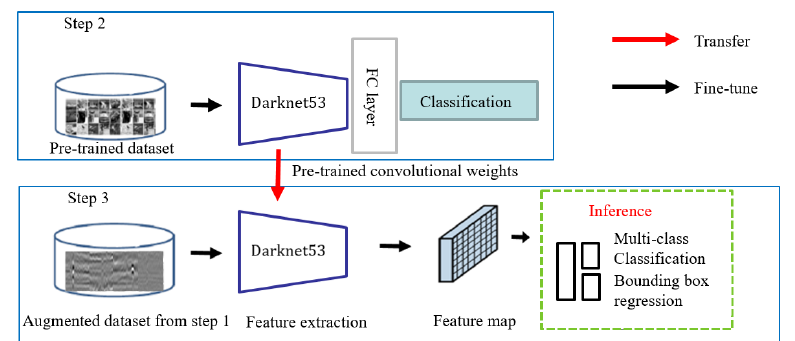
Figure 1. Target Detection from GRP imagery based on Convolutional Neural